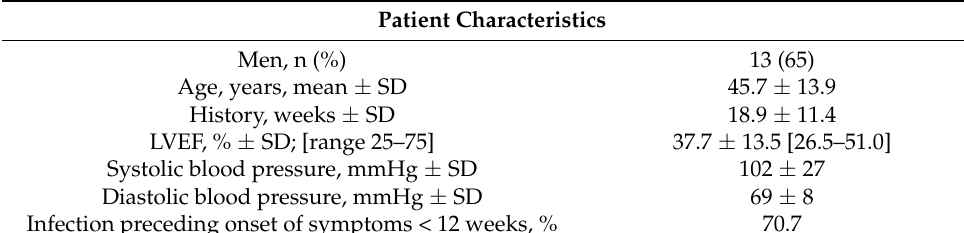
Table 1. Baseline characteristics of